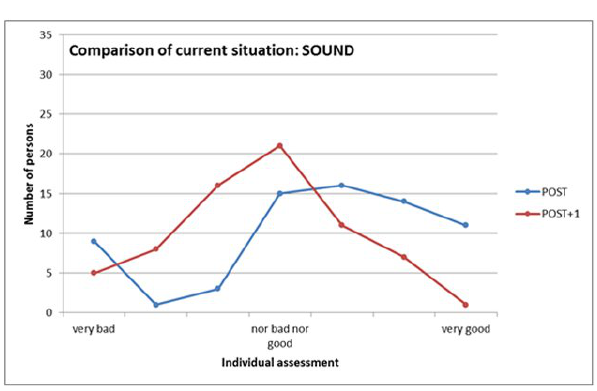
Figure 8: Comparison of the individual responses for Q1 over time (SOUND aspect).